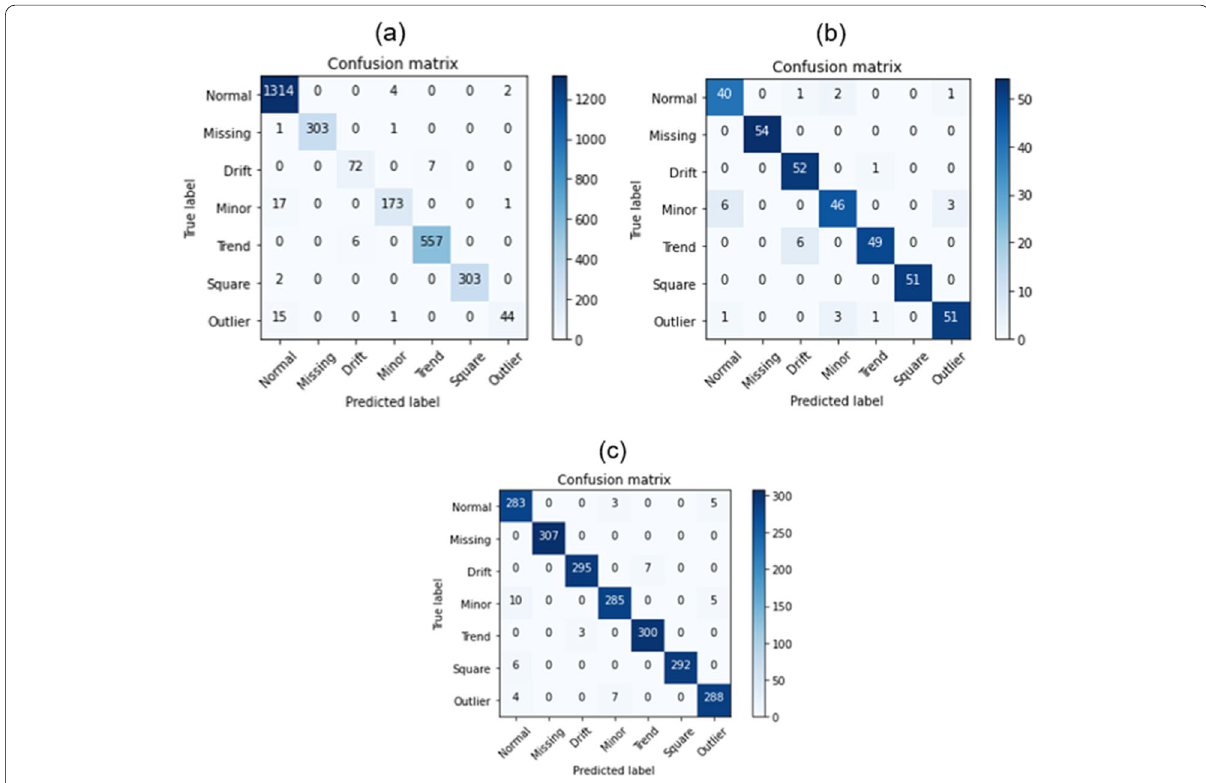
Fig. 9 Confusion matrix against the fifth trial testing set: a C1, b C2, and c C3